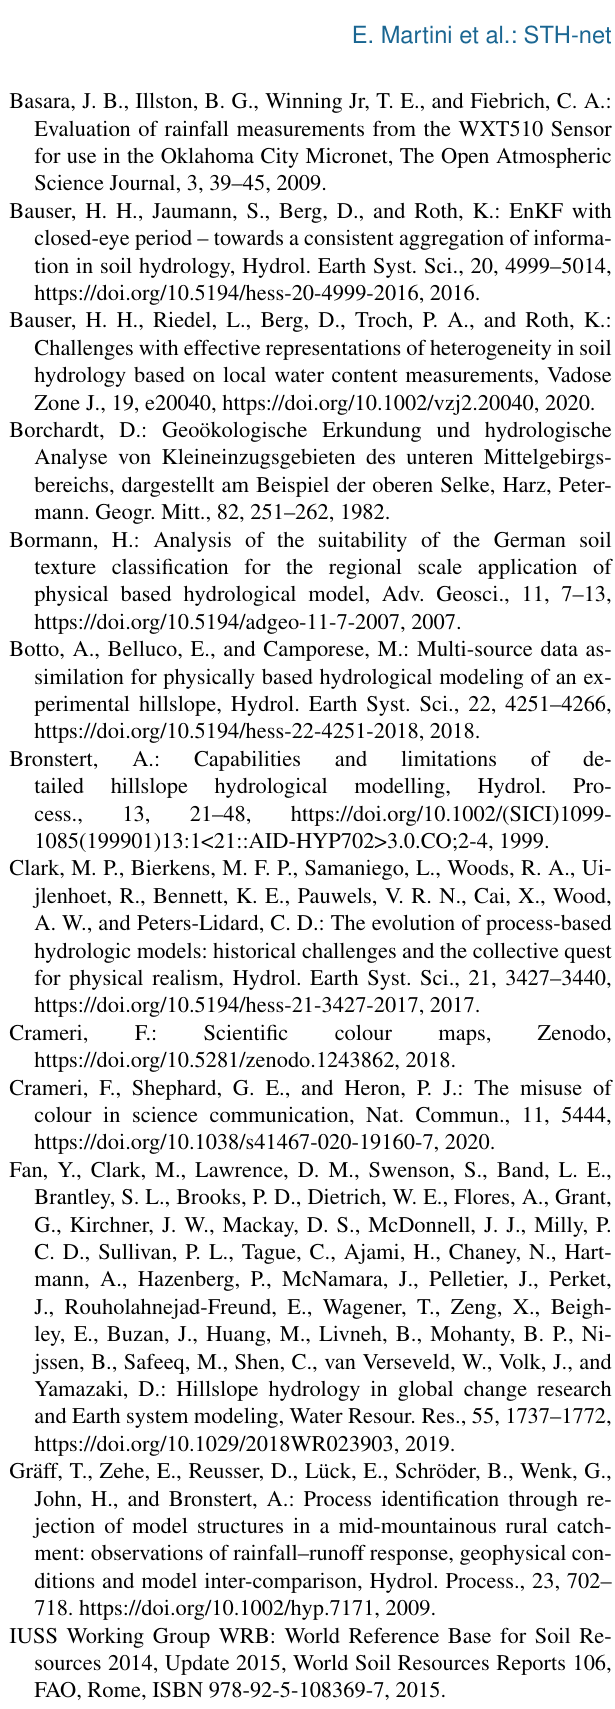
ing a scientific colour scale from Crameri (2018) chosen